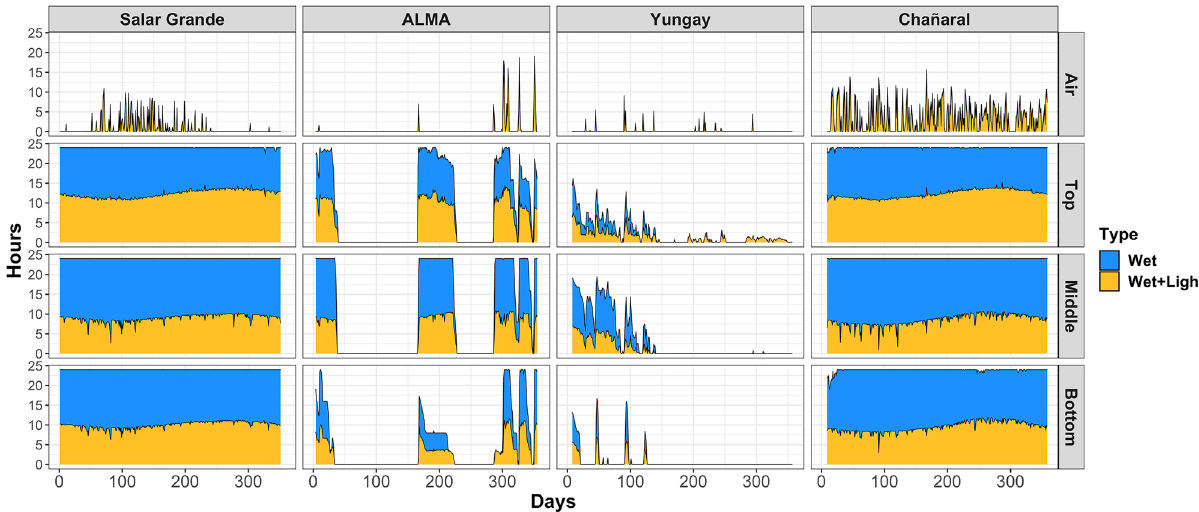
Figure 2. Daily hours of wet and wet + light conditions throughout data collection in the air and inside the halite nodules at each site. Salt deliquescence enables wet conditions inside halite nodules at RH > 75%. In the air, wet conditions occur at RH > 95%. Wet + light conditions occurred when RH values above respective thresholds co-occur with PAR > 0.01μmol photons m -2 s -1 masl) exhibited a dry regime with maximum daily RH air above 95% for only 24 days and minimum daily RH air values around 10%. The ALMA site also experienced three events of atmospheric precipitation (rain or snow) at approximately days 10, 160, and 280 after the transplant. During the wetting events at days 10 and 280, mini- mum daily temperatures were above 10 °C, whereas they fell below 0 °C during the wetting event at day 160. The Yungay site (953 masl) recorded the most variable T air and RH air readings. RH air values were generally low throughout data collection with mean values above 50% on only 15% of collected days and only 16 days recorded with RH air values ≥ 95%. The Chañaral site (848 masl) was similar to Salar Grande but with more variable daily values for RH air and slightly cooler daily temperatures. Chañaral recorded 239 days with peak RH air ≥ 95%. Humidity conditions inside halite nodules (RH halite ) varied significantly between sites (Fig. S3B). At Salar Grande, the mean RH halite remained near 75% for the entire recorded period. No differences were observed between the top, middle, and bottom sections of the nodules. At the ALMA site, the mean RH halite was initially high (75%) but dropped to values around 25% approximately 50 days after the transplant. At around day 160, cor- responding to a wetting event recorded by the atmospheric sensor (RH air ), the mean RH halite suddenly increased to 75%. The RH halite remained at 75% for 65 days and subsequently dropped over a period of 55 days to reach values around 25%. At approximately day 280, corresponding to another atmospheric wetting event, a second spike in the mean RH halite to 75% was observed. Values remained high, albeit variable, until the end of the recorded period. Minor differences were observed between the top, middle, and bottom sections of the nodules. At the Yungay site, the mean RH halite was initially high (c.a. 75%) but quickly declined to values between 50 and 60%. The mean RH halite oscillated between those values for most of the recorded period, except for short intervals when it dropped to values close to 25%. Similar to ALMA, minor differences were observed between the nodules’ top, middle, and bottom sections. In the Chañaral site, the mean RH halite values remained constant near 75% for the entire recorded period, which was similar to the control site in Salar Grande. Temperature conditions inside the nodules were similar at all sites and comparable to the air temperature (Fig. S3A). These findings indicated that the mean RH halite values point to the continuous presence of saturated NaCl brines filling the pore spaces of the halite nodules in Salar Grande and Chañaral. In ALMA, halite nodules went through three “wet periods” when mean RH halite values were consistent with the presence of saturated NaCl brines (RH halite = 75%), interspaced with two “dry periods” when mean RH halite remained low. In Yungay, halite nodules progressively dried out with no observable wet/dry cycling. Daily cumulative hours of wet and wet + light conditions further emphasized the different environmental regimes experienced by communities inside transplanted nodules compared to nodules at the control site (Fig. 2). At Salar Grande and Chañaral, conditions inside the nodules (top, middle, and bottom) were compatible with metabolic activity within three separate periods, each lasting 50–65 days and separated by dry spells lasting 50–100 days. At the Yungay site, conditions inside the nodules (top and middle) were compatible with metabolic activity at the beginning of the transplant experiment but slowly declined during the first 150 days. After that, only the top of the halite nodules experienced brief periods compatible with metabolic activity last- ing several hours.